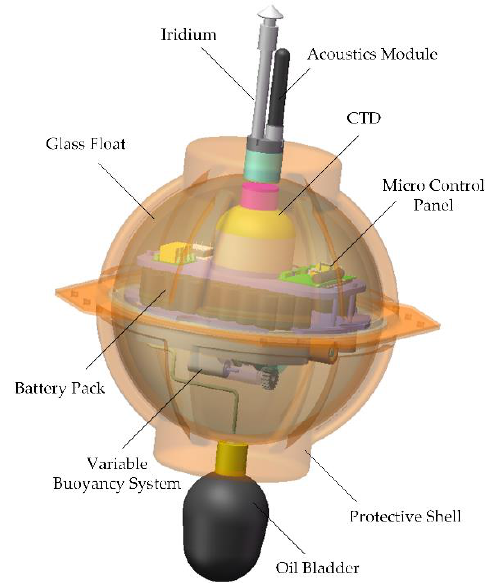
Figure 2. Outside view of floating ocean seismograph.